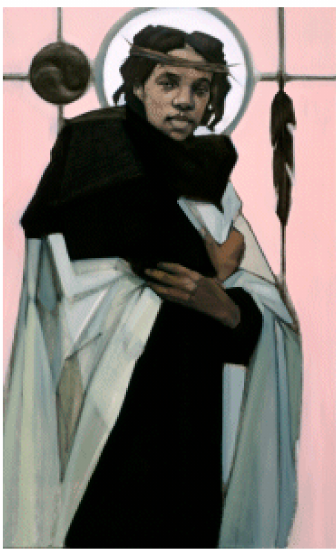
Figure 8. “Jesus of the People” by Janet